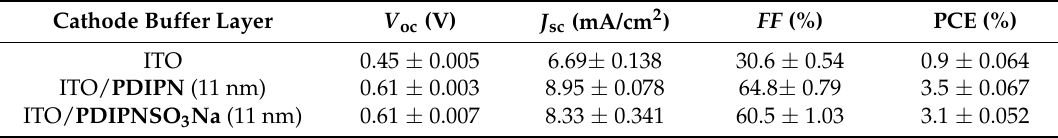
Table 2. Device Performance of the Inverted P3HT:PC 61 BM Polymer Solar Cells with Various ETLs. Cathode Buffer Layer